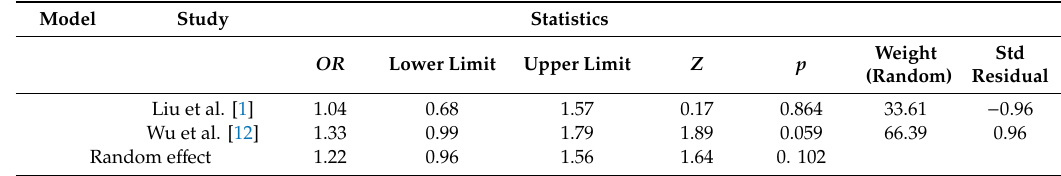
Table 5. Summary e ff ect sizes for triglycerides (TG) serum levels and Alzheimer’s disease (AD).